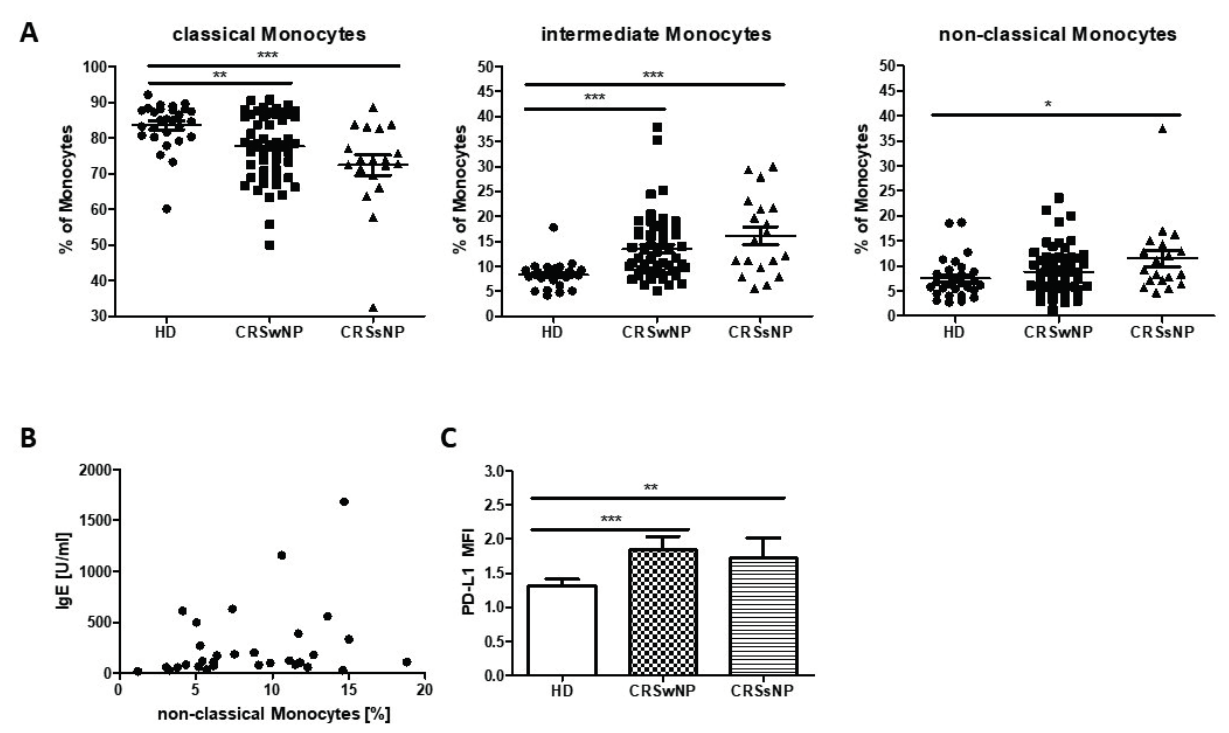
Figure 1. Flow cytometric analysis of monocytes. A: Whole blood analysis revealed a decrease of classical monocytes and an increase of CD16+ inter- mediate and non-classical monocytes in CRSwNP (n = 56)/CRSsNP (n = 16) patients and healthy donors (HD) (n = 29). B: Pearson correlation of IgE serum levels and percentage of non-classical monocytes in peripheral blood of CRSwNP patients (n = 56). C: FACS analysis of PBMC from CRSwNP (n = 30)/CRSsNP (n = 8) patients and healthy donors (n = 29) revealed increased PD-L1 expression on monocytes from CRSwNP and CRSsNP